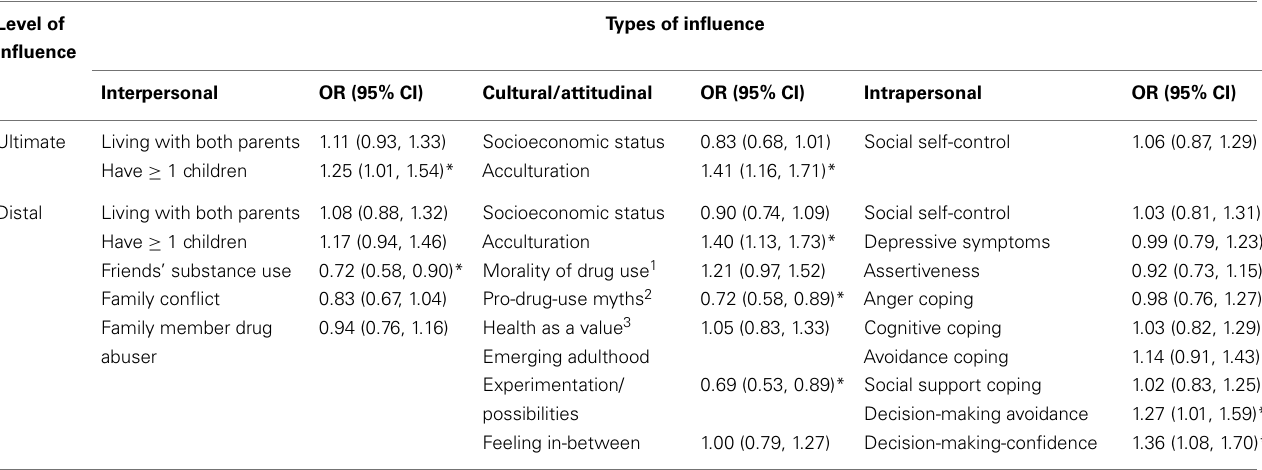
Table 2 | Summary of hierarchical regression analysis for social/interpersonal variables predicting marijuana cessation at the 1-year follow-up. Level